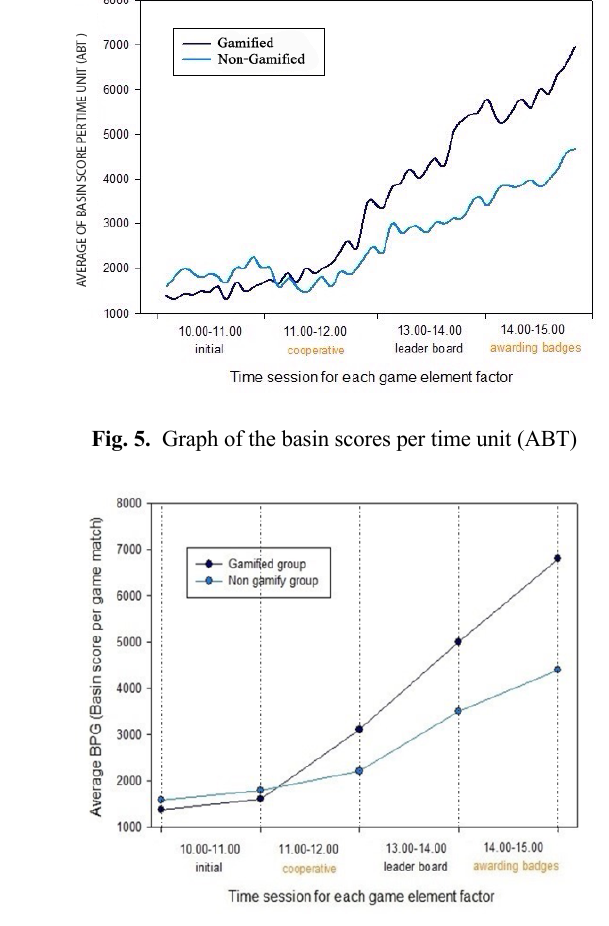
Fig. 6. Graph of the normalized slope of ABT (basin scores per time unit) Table 1. Angle difference (degree) of ABT for each game